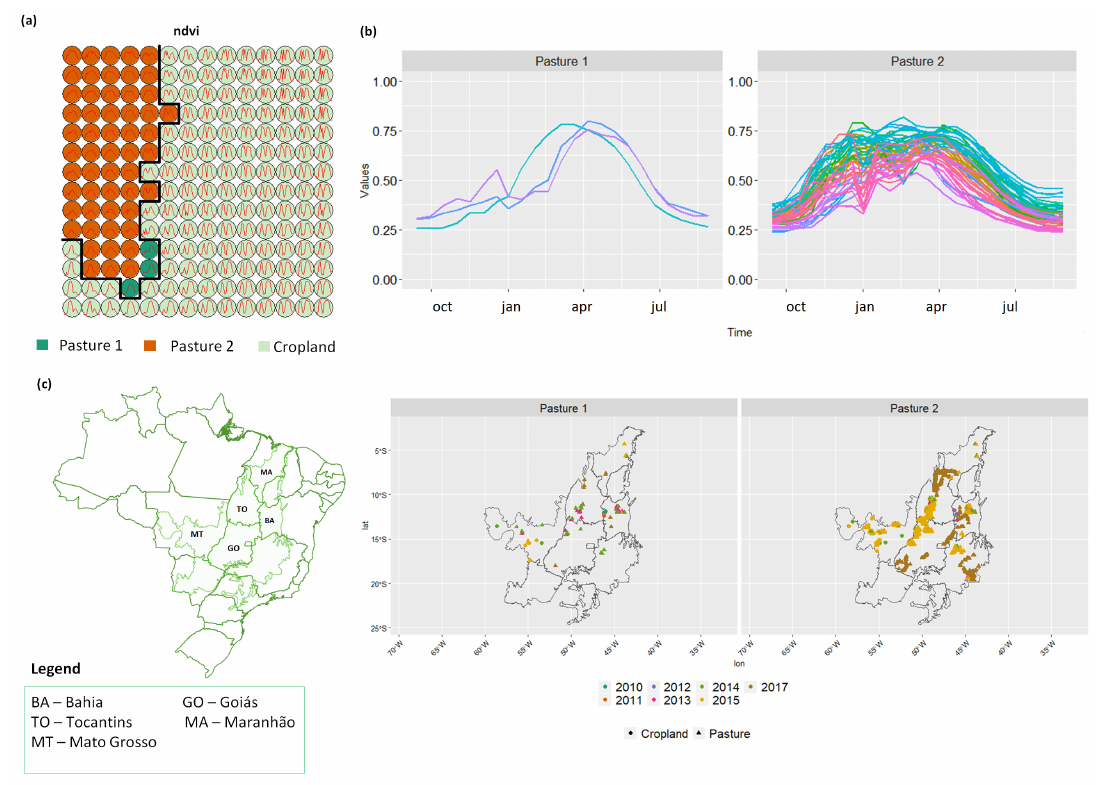
Figure 13. Cluster of pasture. ( a ) SOM grid with subclusters of pasture. ( b ) Weight vectors of each subcluster. Each line represent a neuron. ( c ) Spatial subclusters.